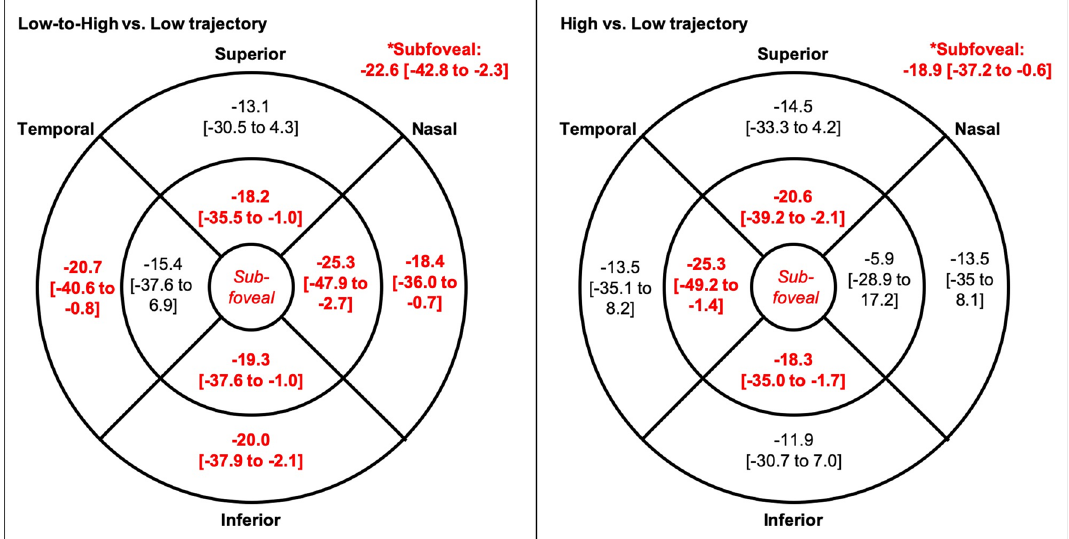
Figure 3. Mean difference [and 95% confidence interval] in choroidal thickness (μm) at the central (0.5-mm radius around the fovea), inner (between 0.5- and 1.5-mm radius around the fovea), and outer macula between (1.5- and 3.0-mm radius around the fovea) between c-reactive protein trajectory groups. Statistically significant positive associations shown in bold and red ( p < 0.01), corrected for sex, ethnicity, BMI, ocular measures, exposure to cigarette smoke, and time of day of SD-OCT imaging. Reference = “Low”